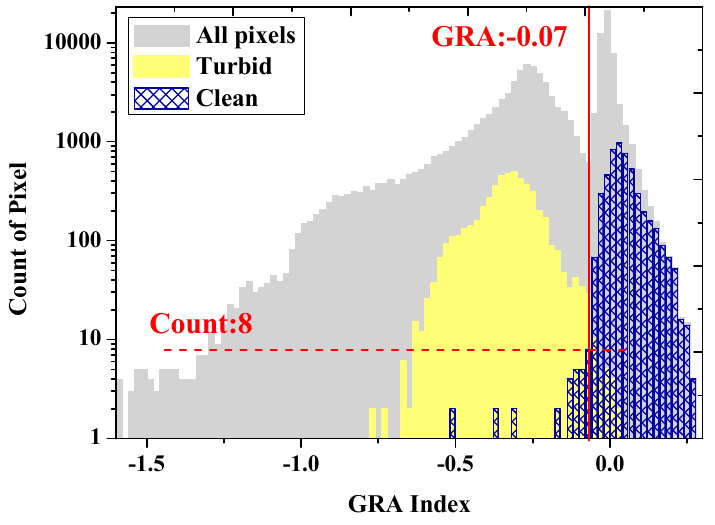
Figure 5. Histogram distribution of the GRA index of water pixels where the label “All pixels” represents all the study lakes in this study, and the label “Clean” and “Turbid” are, respectively, the clean and turbid water pixels that we manually interpreted referenced from water quality parameters and spectral curves.